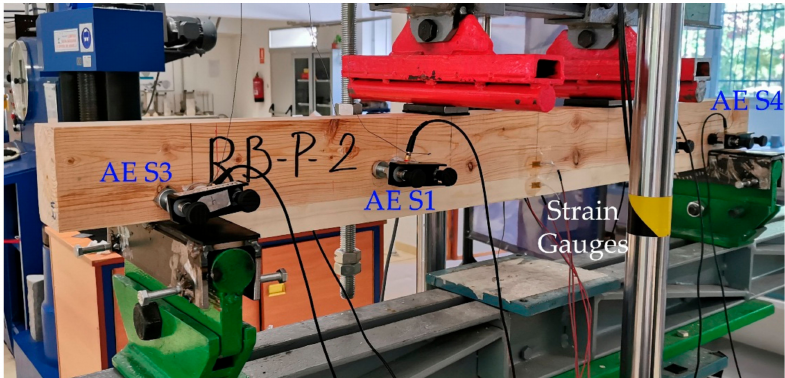
Figure 2. Image of the specimen SP during the bending